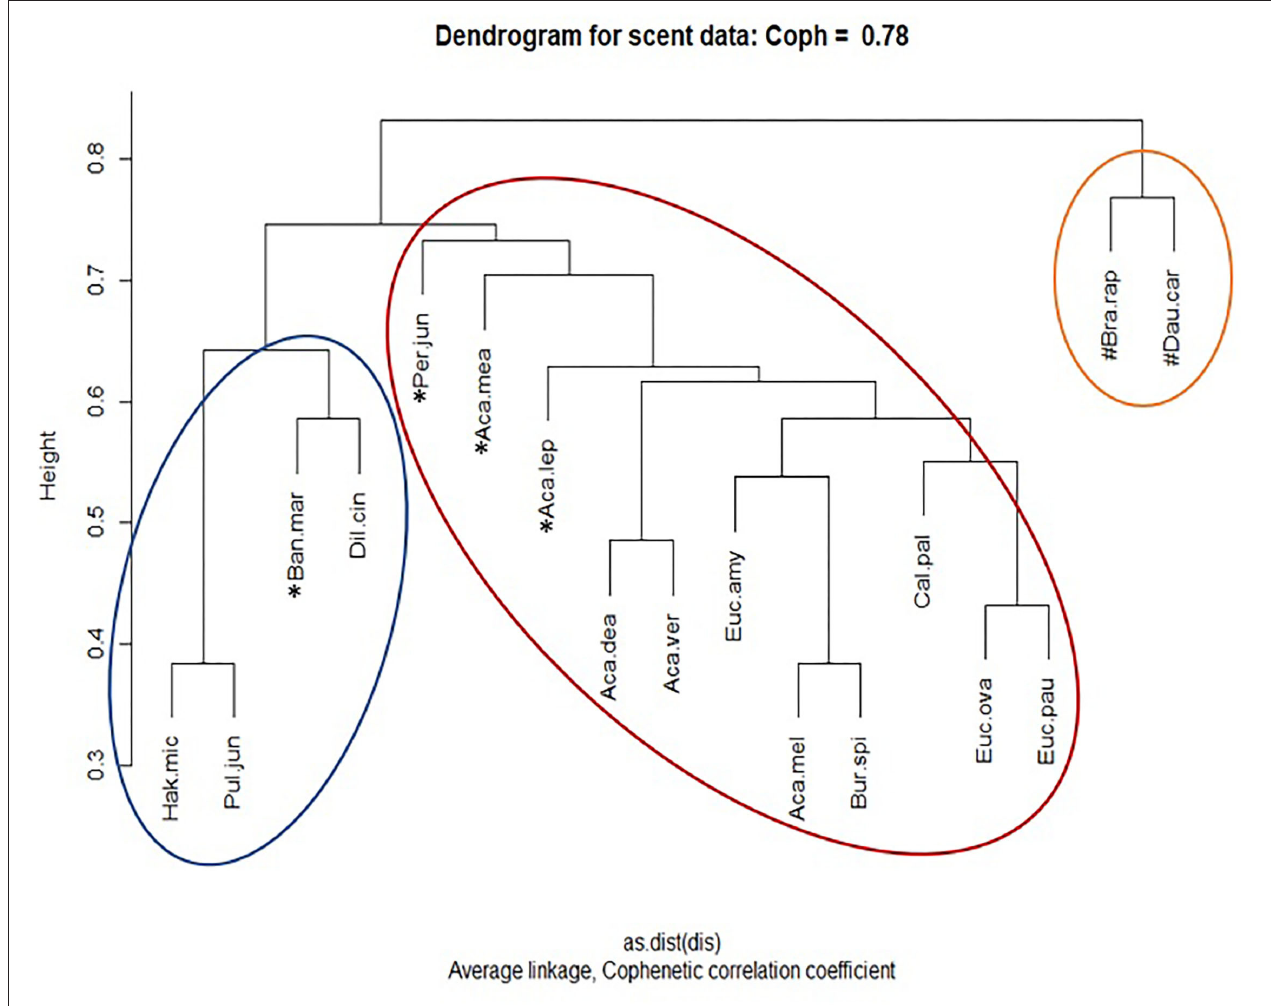
FIGURE 6 | Average-linked hierarchical clustering dendrogram of species-level floral volatile presence-absence data. Total floral volatiles included: any compound present in any sample per species. Species that are clustered differently depending on the scent profile method are marked with an asterisk. Three broad clustering groups were observed and are circled. For species abbreviation keys, refer to Table 1 and Section Floral Scent Sampling and